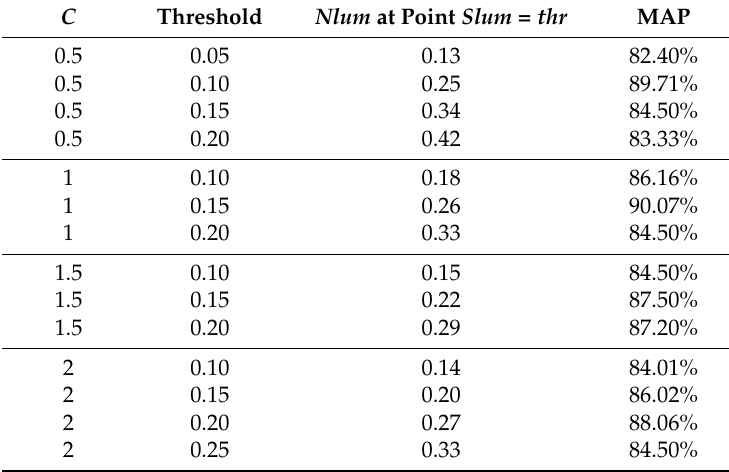
Table 4. MAP analysis after applying DASTM on KTSD for different C and thr